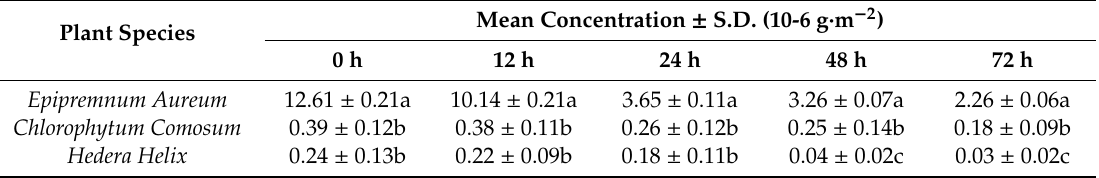
Table 3. Transpiration rate of the three plants under di ff erent exposure